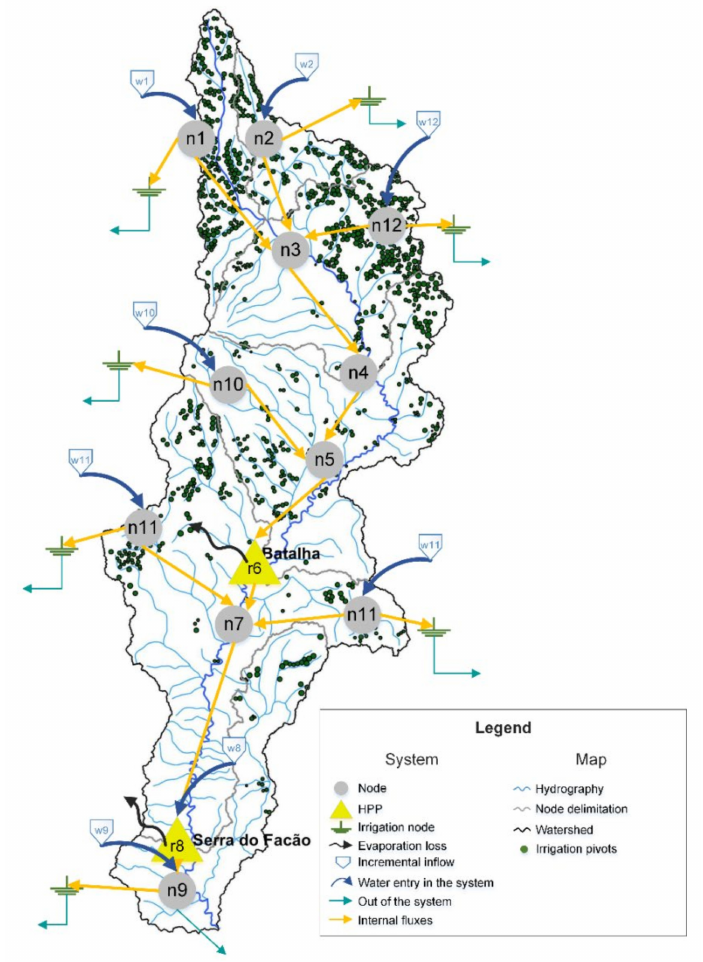
Figure 2. S ã o Marcos Basin model